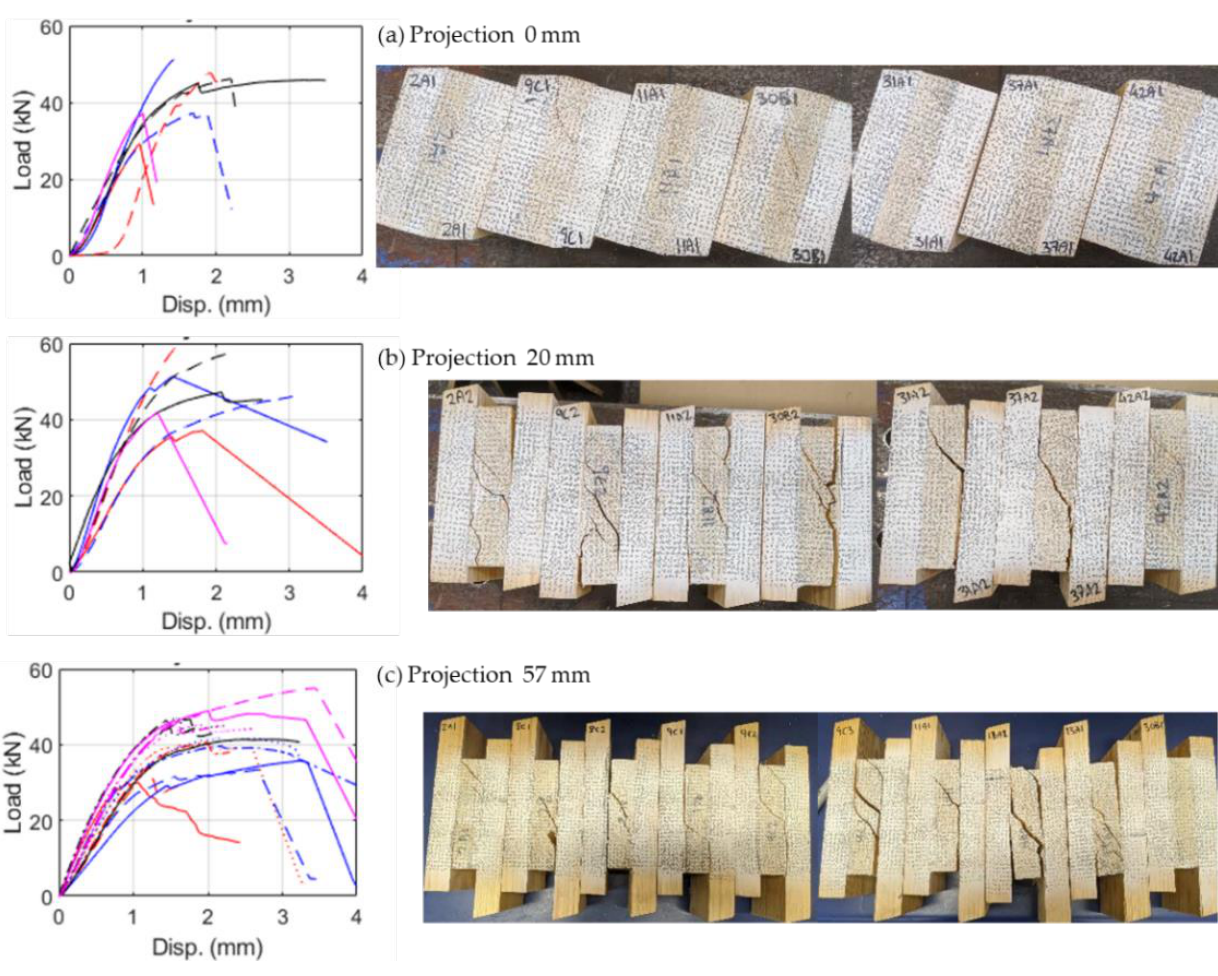
Figure 16. Load vs displacement curves, and relevant failure modes of the samples due to various projection length.